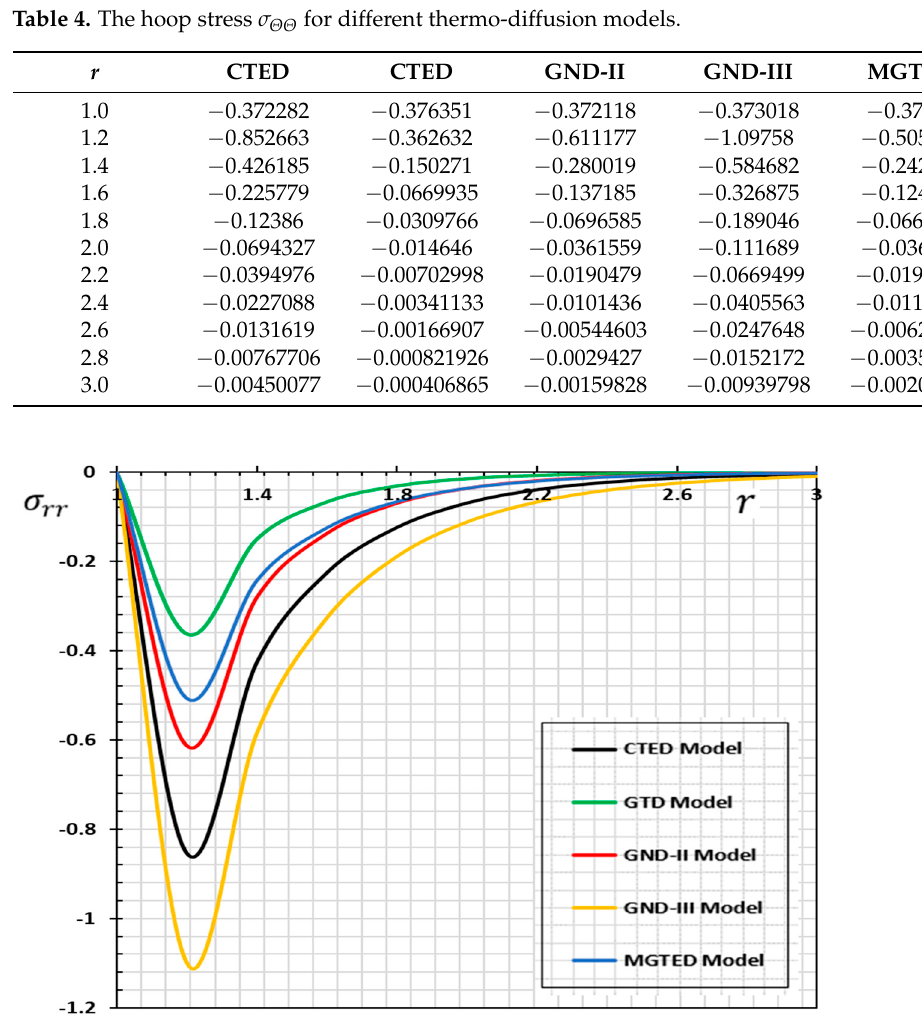
Figure 4. The hoop stress 𝜎 (cid:2944)(cid:2944) for different thermo-diffusion models. The radial thermal stress 𝜎 (cid:3045)(cid:3045) starts at zero, filling the conditions of the proposed problem, then decreases rapidly until at the peak point it reaches its maximum value, and then decreases steadily until it disappears to zero (see Table 3 and Figure 3). With the hoop stress 𝜎 (cid:2944)(cid:2944) , the same previous behavior occurs except that it starts with a negative value different from zero at the surface of the spherical cavity. In behavior and principles, the variations in GTD-, GND-II-, and MGTED-generalized thermal diffusion models are similar together. The existence of the relaxation parameters of generalized thermoelasticity (GND-III) and the diffusion that have been integrated into the current model (MGTED) have a major effect on the properties and actions of the vibrations of the different distributions.